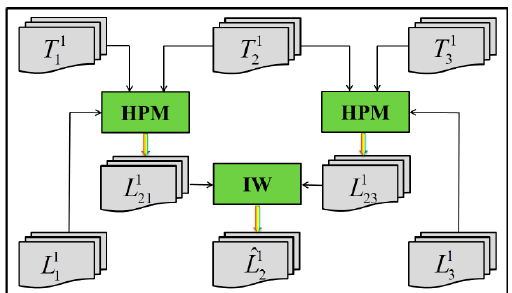
Figure 3. Flowchart of our fusion model. HPM is high pass modulation module; IW is an indicative weighting module.